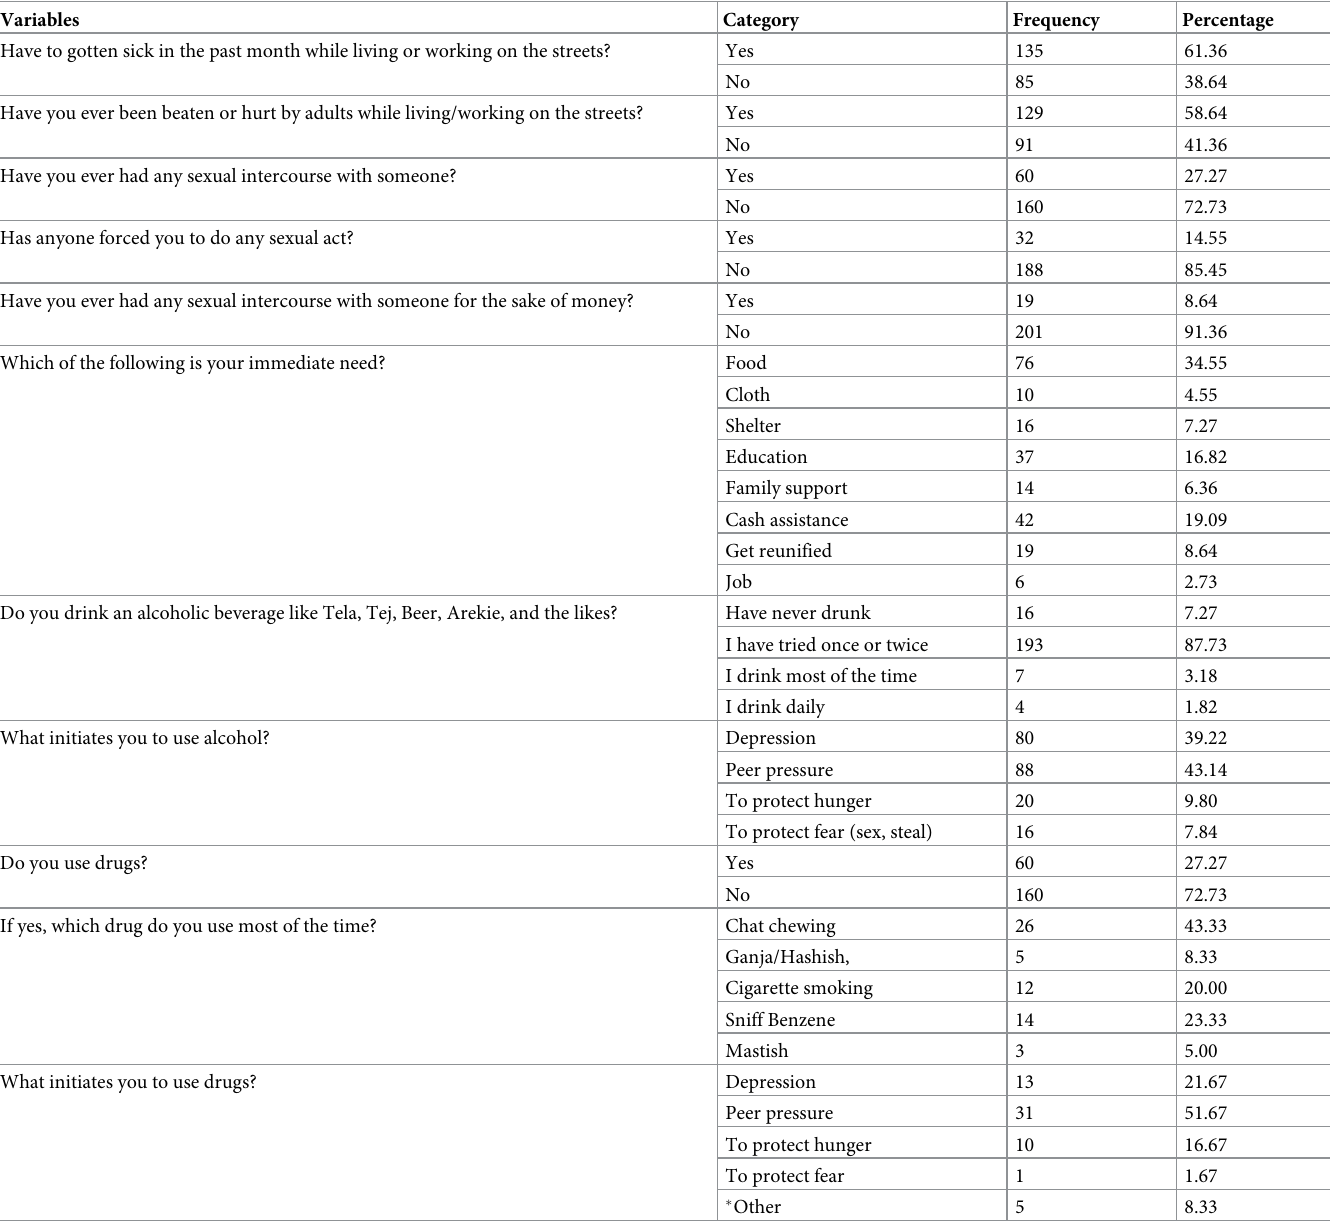
Table 5. Health status and substance use among study participants in Harar city, Ethiopia, 2021.